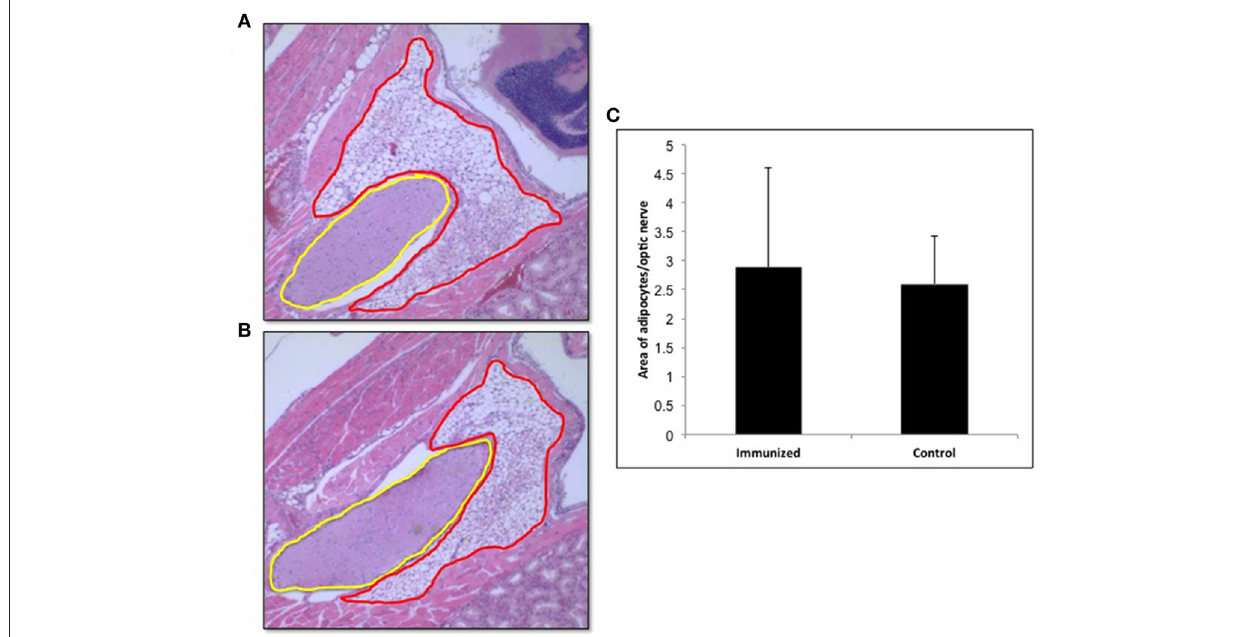
FIGURE 8 | Adipogenesis in the retro orbital of immunized animals: Images of hematoxylin and eosin (H&E) stained slides were obtained using the Hamamatsu NanoZoomer digital scanner at 20x magnification and analyzed and depicted here by NDP.view2 software. Representative images of (A) Adipose tissue (ROI marked in red) around the optic nerve (ROI marked in yellow) of a control mouse. (B) Adipose tissue around the optic nerve of the TSHR immunized mice (C) To quantitate the changes in adipocytes in the control and immunized animals we used Image J on images at 10x magnification. The area of adipose was normalized by the area of the optical nerve on the same image for each orbit of animal. The immunized mice adipocyte to optic nerve area ratio was 2.88 ± 3.46 and that for the control mice was 2.59 ± 1.66. No significant difference in adipogenesis was seen in these immunized